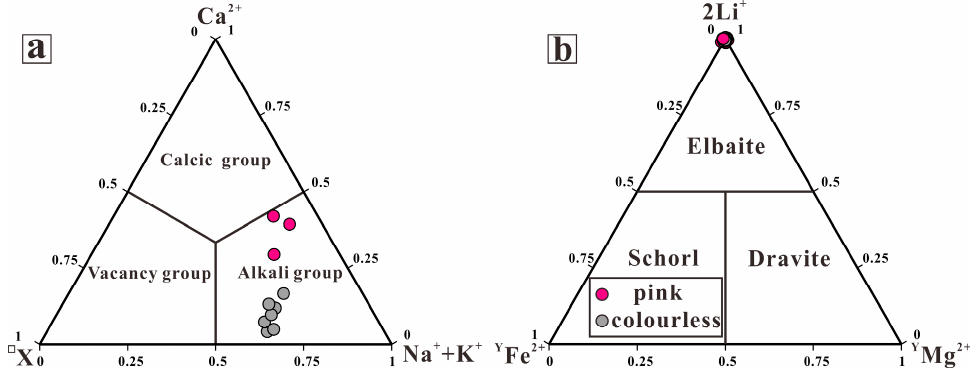
Figure 4. ( a ) Classification diagram for tourmalines based on ( a ) X-site occupancy; ( b ) secondary division is made according to the dominant occupancy of the Y site (Mg 2+ , Fe 2+ and 2Li + ) [1].